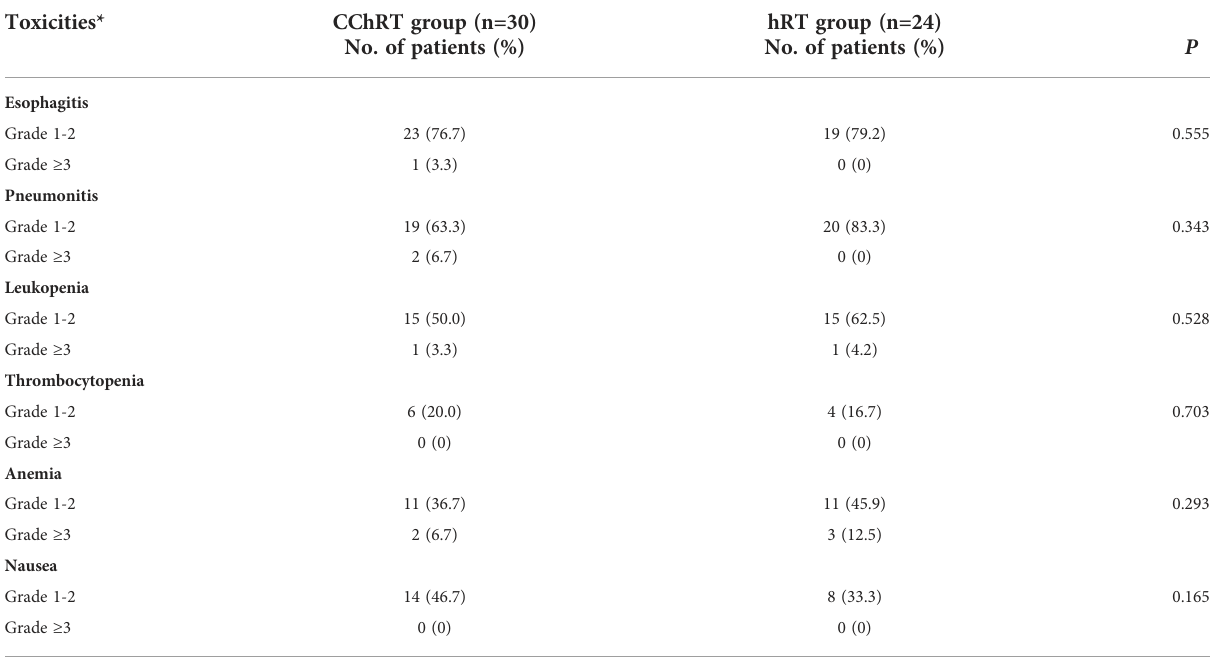
TABLE 3 Toxicities